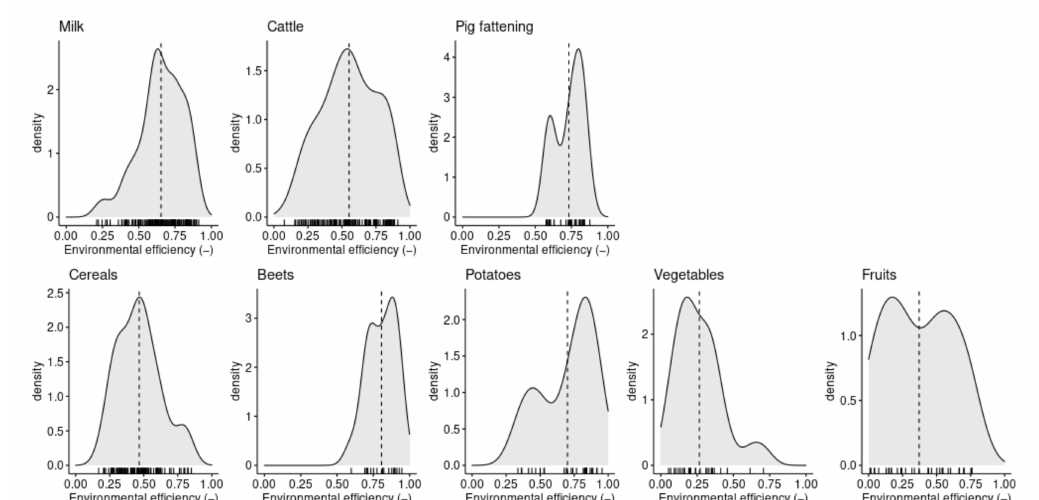
Figure 3. Distribution of environmental efficiency for product groups. The dotted line marks the average environmental efficiency for each product group. The tick marks below the x -axis denote actual observations. The density is retrieved by calculating the kernel density estimate, i.e., by weighting the distances of all the data points at each value. The more points nearby, the higher the estimate. The probability of finding a value between a given interval is the area below the curve, confined by this interval.